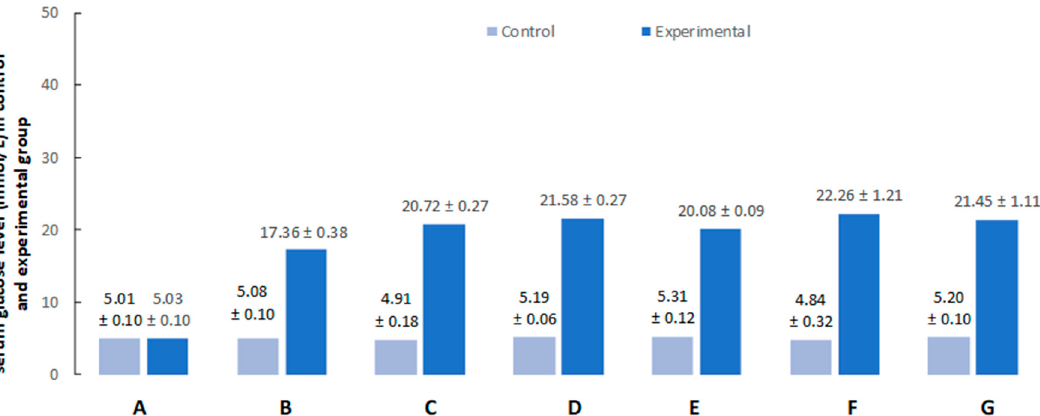
Figure 2. Serum glucose levels after citrate buffer (light blue bars) or streptozotocin (dark blue bars) administration ( A ) at the beginning of the experiment, ( B ) after 1 week, ( C ) after 2 weeks, ( D ) after 3 weeks, ( E ) after 4 weeks, ( F ) after 5 weeks, and ( G ) after 6 weeks.